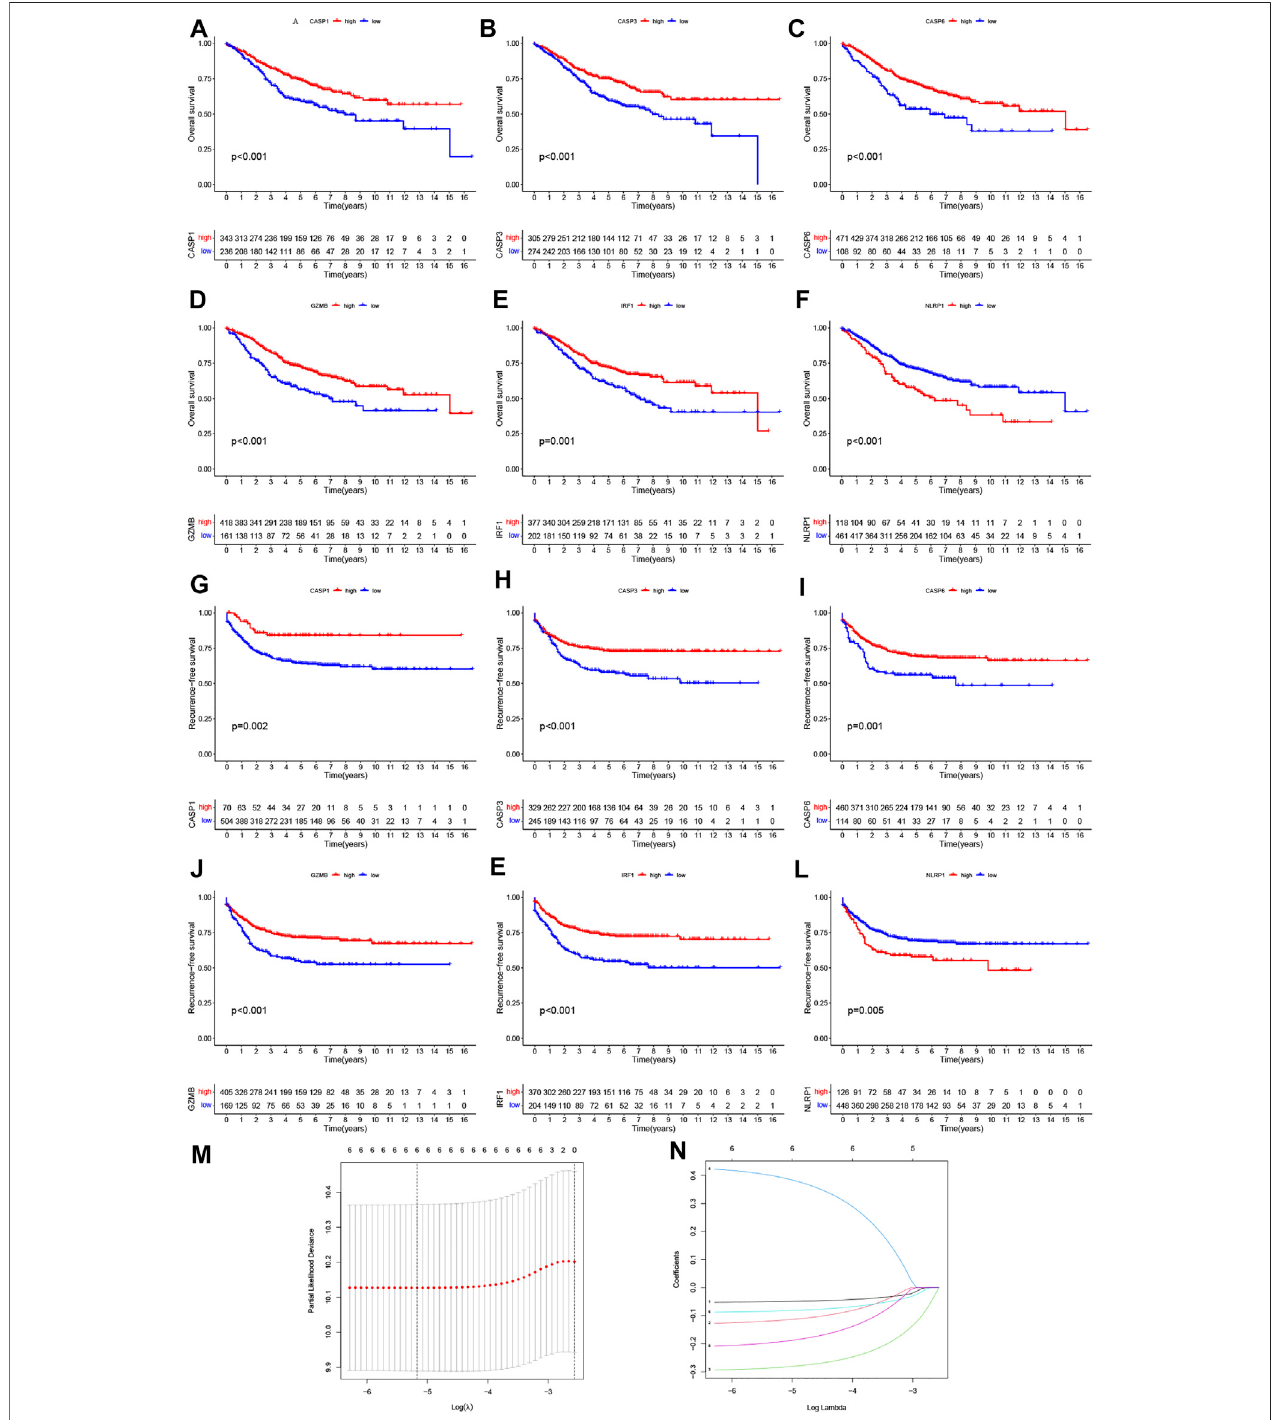
FIGURE 4 | Prognostic value of six PRGs in CRC. The Kaplan – Meier curves ofCASP1 (A,G) , CASP3 (B,H) , CASP6 (C,I) , GZMB (D,J) , IRF1 (E,K) , and NLRP1 (F, L) for the low- and high-expression groups with the cut-off value 2.732 for OS and 2.281 for RFS in GSE39582 cohorts. (M) Cross-validation for tuning the parameter selection in the LASSO regression. (N) LASSO regression of the OS-related PRGs.